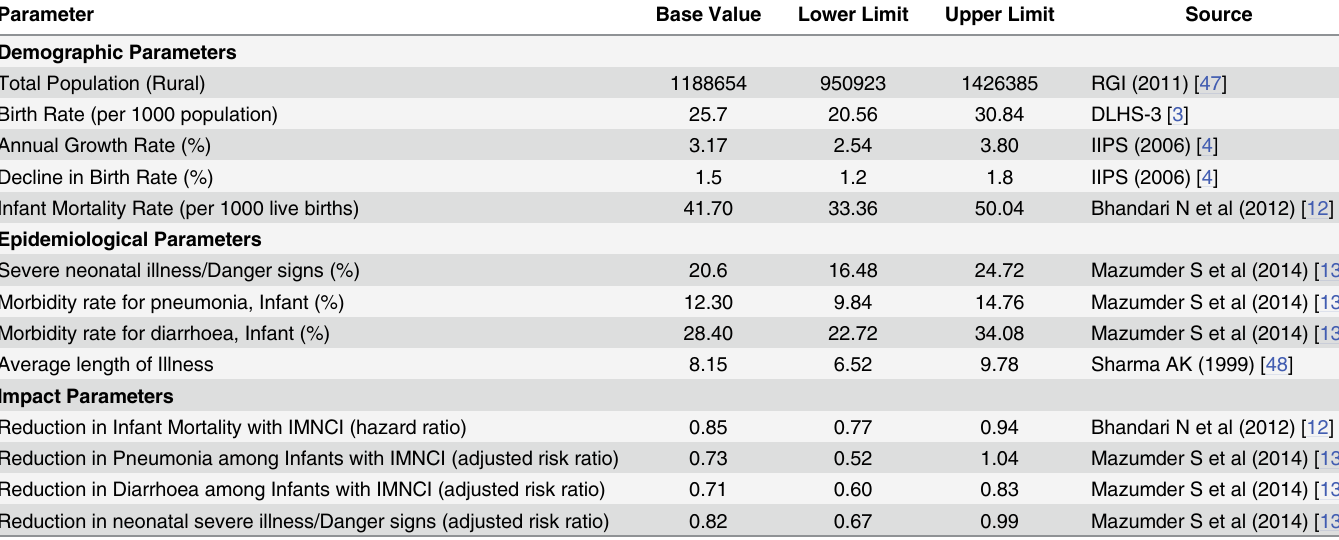
Table 1. Demographic, Epidemiological and Impact Parameters for IMNCI Cost Effectiveness Decision